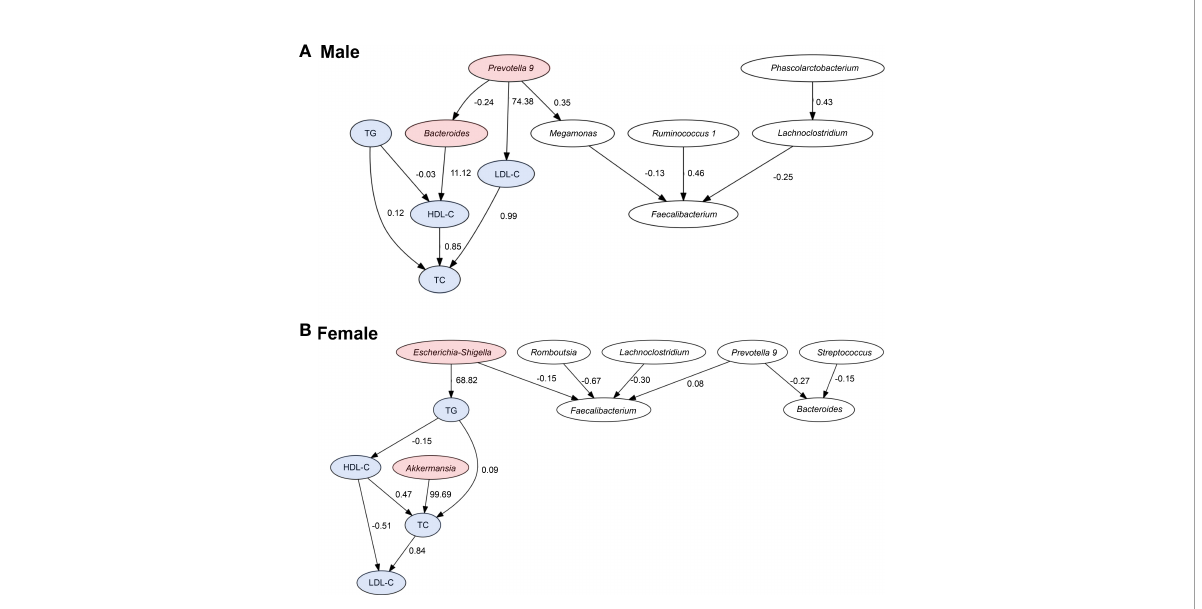
FIGURE 5 Causal relationships between the lipid pro fi les and important bacteria. Arrows indicate the causal relationship between the two connected indicators. Indicators with no causal relationship between them were not shown in the fi gure. Red: bacteria with an estimated causal relationship with lipids, blue: lipid pro fi le indicators. The values are absolute values of partial regression coef fi